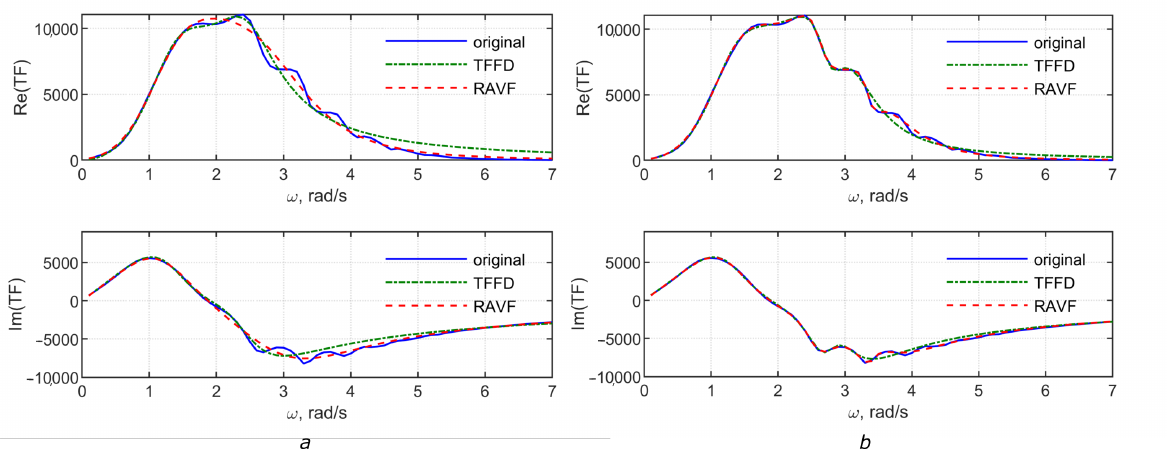
Figure 7. Approximation of transfer function for the buoy with a radius of 2 m: ( a ) TFFD ( k c ≈ 1, (cid:101) r = 0.05) and RAVF ( k c ≈ 1, (cid:101) r = 0.08) methods for the fitting order of 4; ( b ) TFFD ( k r ≈ 1, (cid:101) r = 0.02) and RAVF ( k r ≈ 1, (cid:101) r = 0.06), for the fitting order of 8. The passivity condition was fulfilled. Table 3. Comparison of the two approaches for the buoy with a radius of 2 m for different approxi- mation orders N